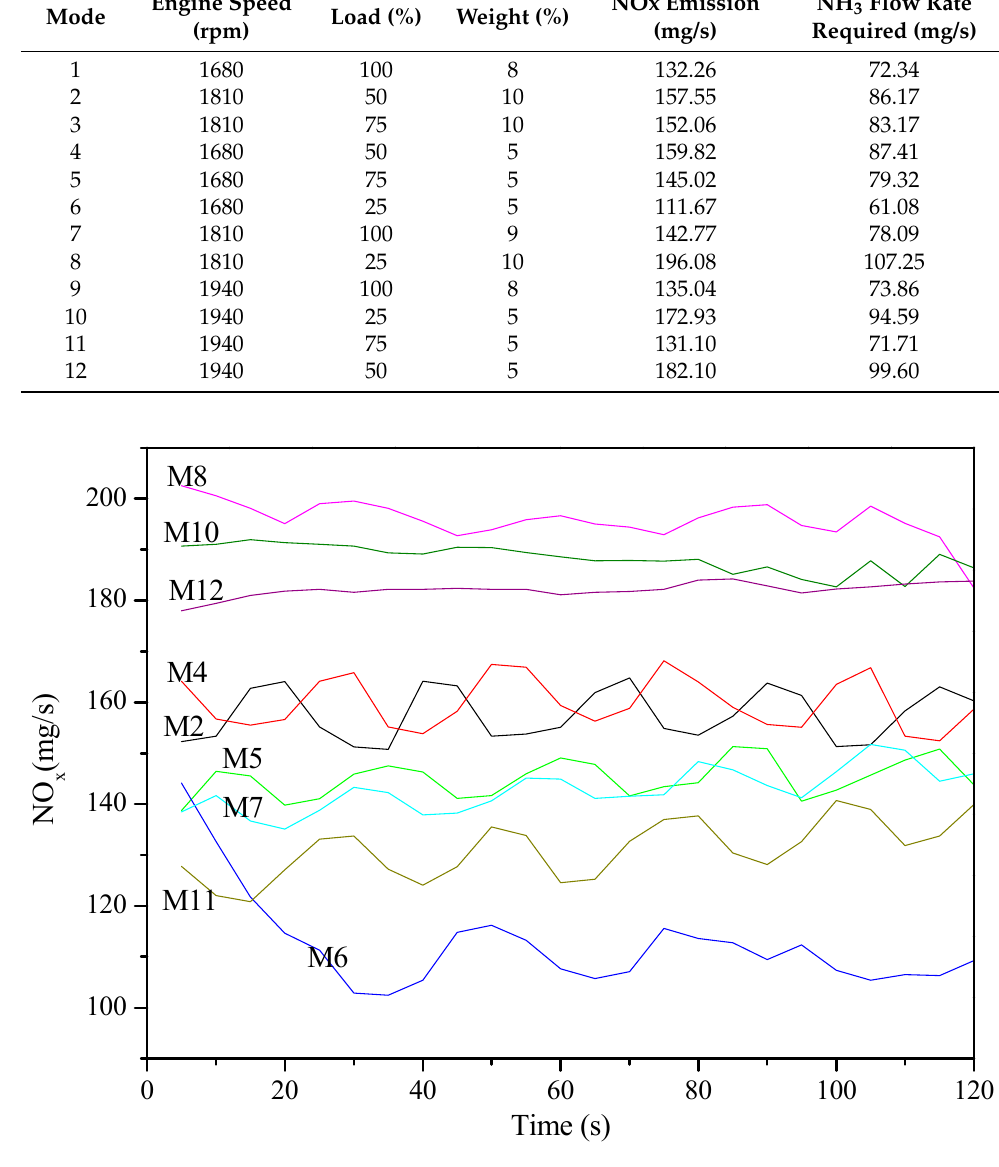
Figure 5. Real-time NOx emission in different operation modes, specifications of the operation modes are given in Table 3 [24]. Table 3. European stationary cycle test modes and corresponding average NOx emission [24].